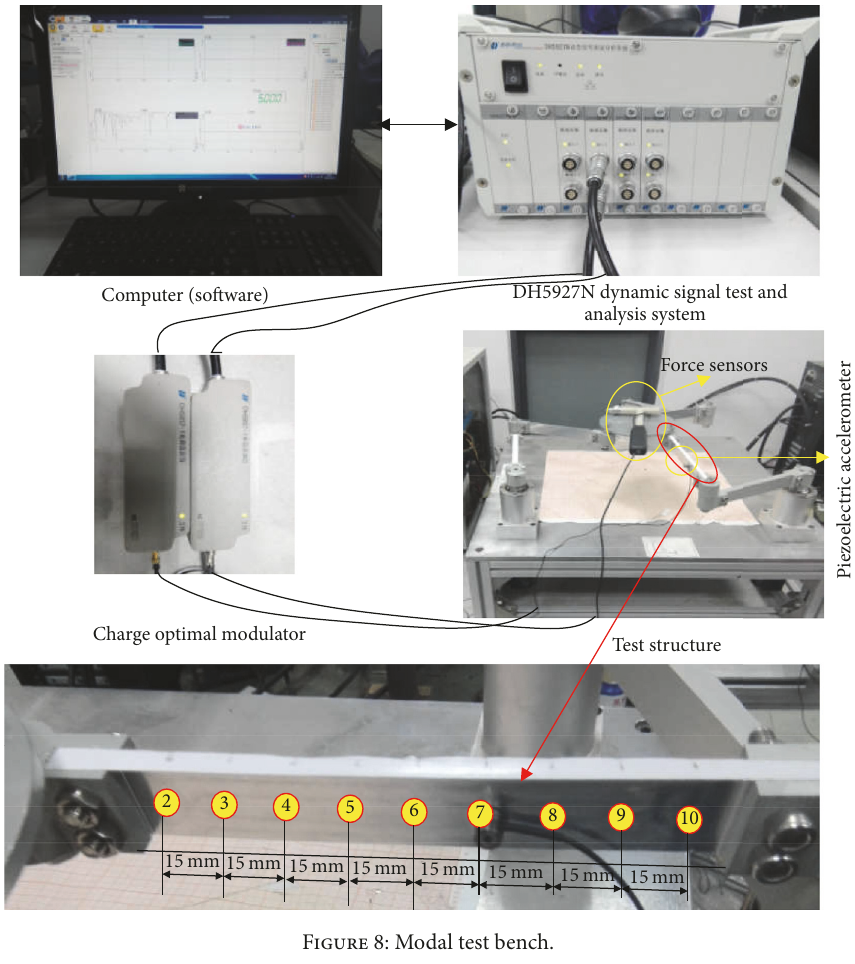
Figure 8: Modal test bench.